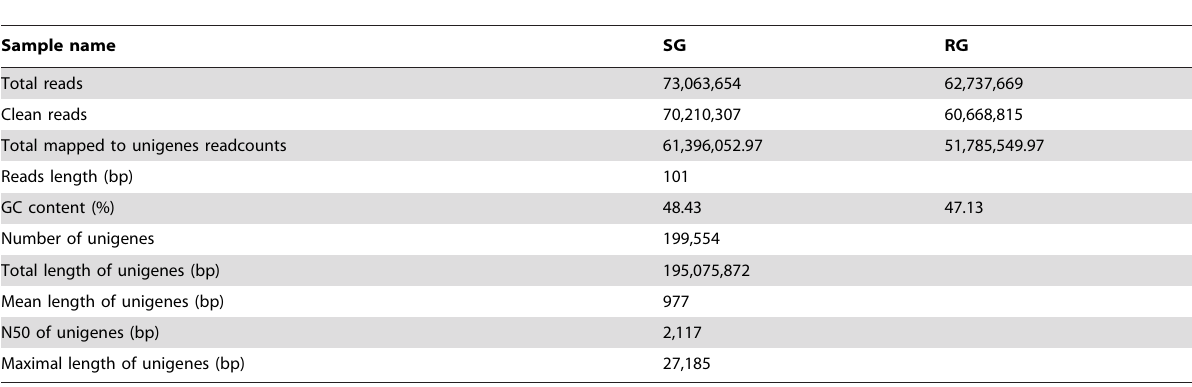
Table 1. Summaries of sequencing cDNA